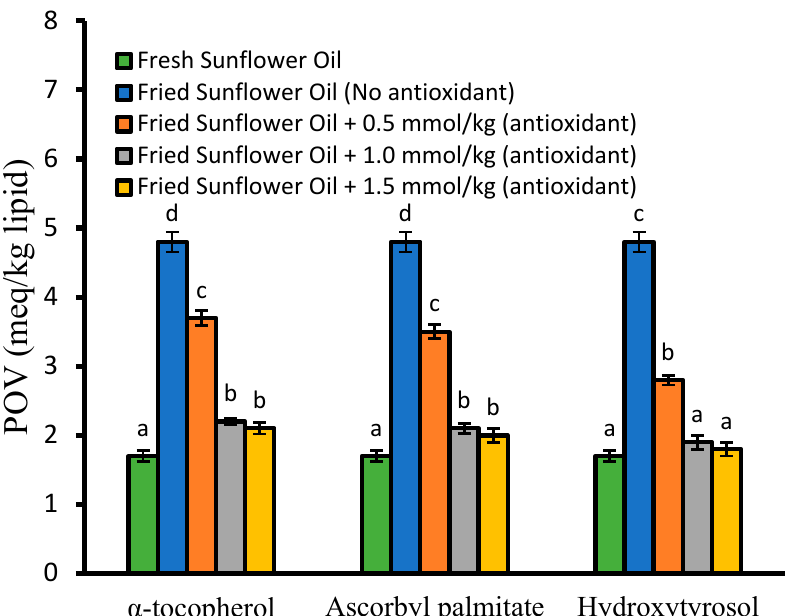
Figure 1. The effect of antioxidant concentration on the stability of sunflower oil (SFO). Values are expressed as mean ± standard deviation ( n = 3). Bars not sharing a common letter are significantly Figure 1. The e ff ect of antioxidant concentration on the stability of sun fl ower oil (SFO). Values are different ( p < 0.05) within each treatment. expressed as mean ± standard deviation ( n = 3). Bars not sharing a common le tt er are signi fi cantly di ff erent ( p < 0.05) within each treatment.